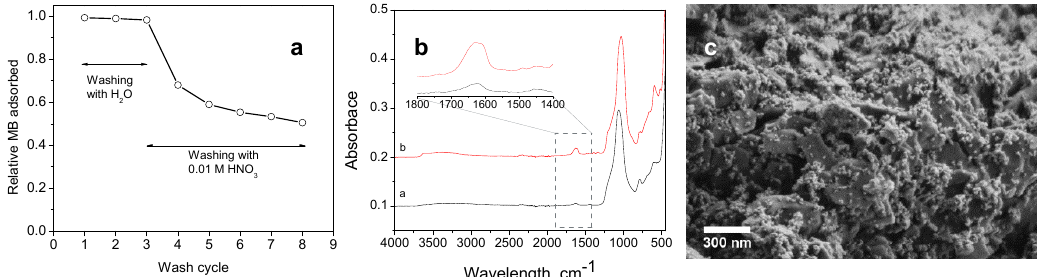
Figure 11. Regeneration process of the catalysts. ( a ) desorption of MB dye from the spent catalyst (SnO2CLI25), ( b ) ATR-FTIR spectra of fresh SnO2CLI25 (black), and used SnO2CLI25 (red), and ( c ) SEM image of SnO2CLI25 after the photocatalytic reaction.